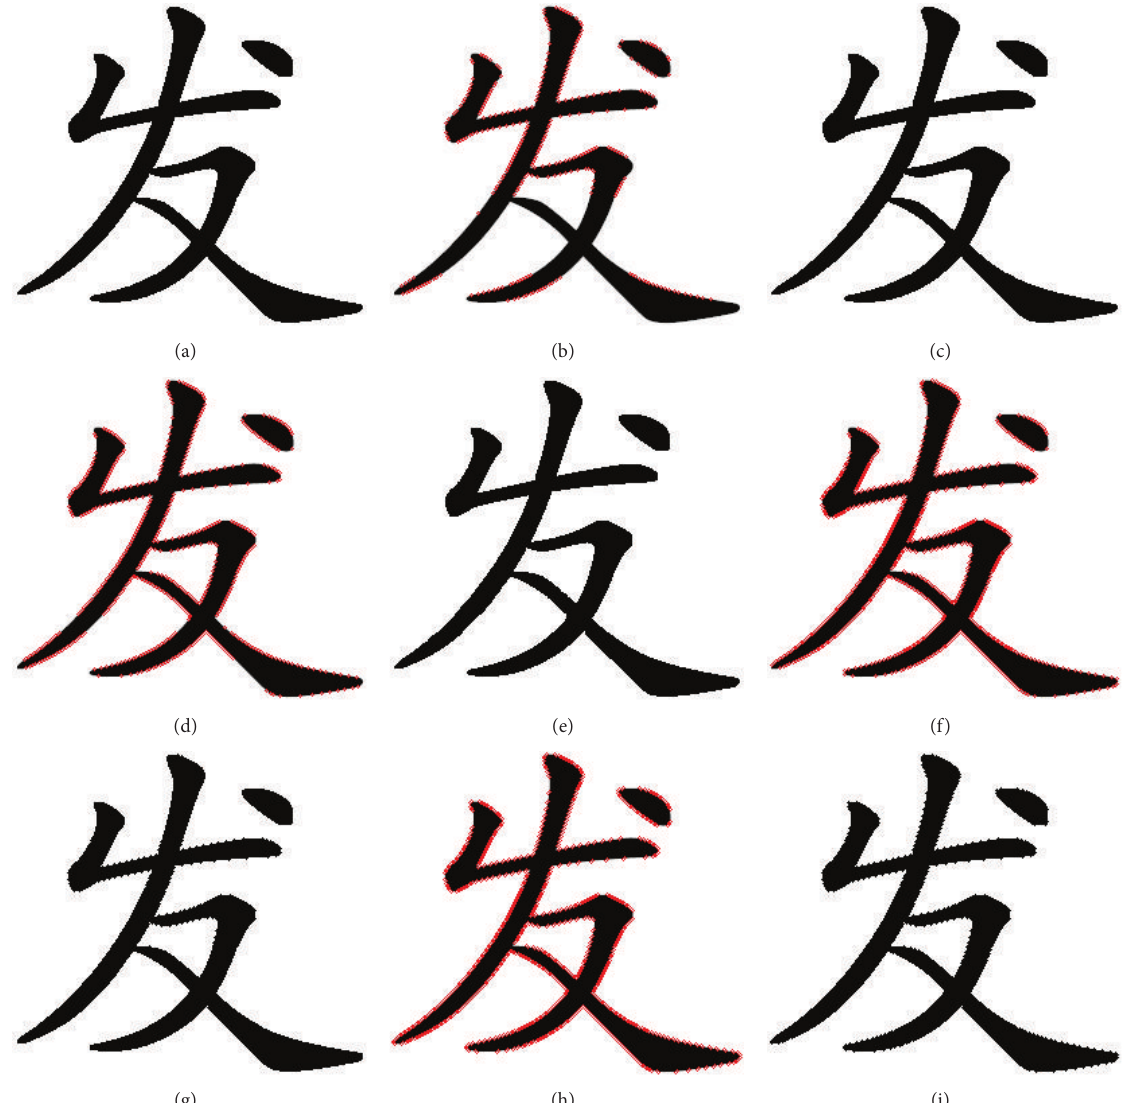
Figure 12: Flipping based on score of smoothness and connectivity. The black pixels count of the original font binary image is 12270; we flipped the original font binary image in every 300 pixels: (a) the original font binary image; (b) flipping position of adding 300 pixels in original font binary image; the red point denotes the flipping position; (c) the font binary image after flipping 300 pixels in original image; (d) flipping position of adding 600 pixels; (e) the font binary image after flipping 600 pixels in original image; (f) flipping position of adding 900 pixels; (g) the font binary image after flipping 600 pixels in original image; (h) flipping position of adding 900 pixels, but the number of flappable pixels is less than 1200; (i) the font binary image after flipping 1200 pixels in original image, but it just flipped 1116 pixels in